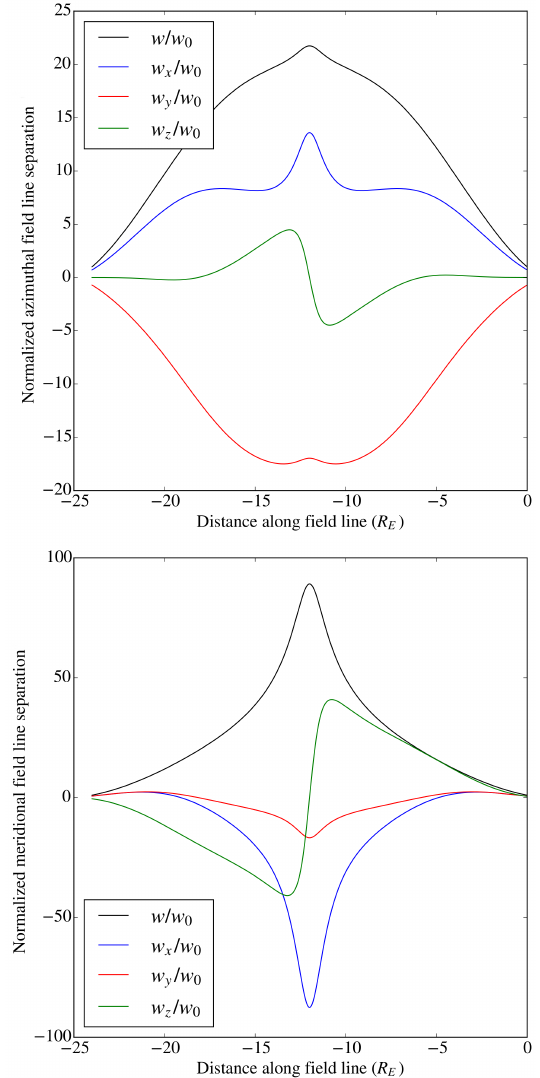
Figure 8. Element of field line separation in the electric field direc- tion, for the field line traced in Fig.